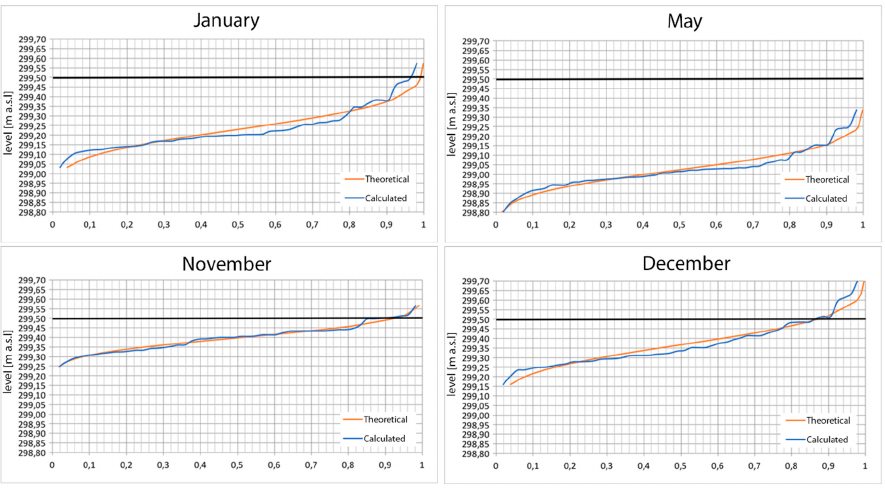
Figure 13. Probability distribution of groundwater levels for some months of the simulated year. The black line represents the buildings’ underground level (5 m below the ground) in the flooded zone.